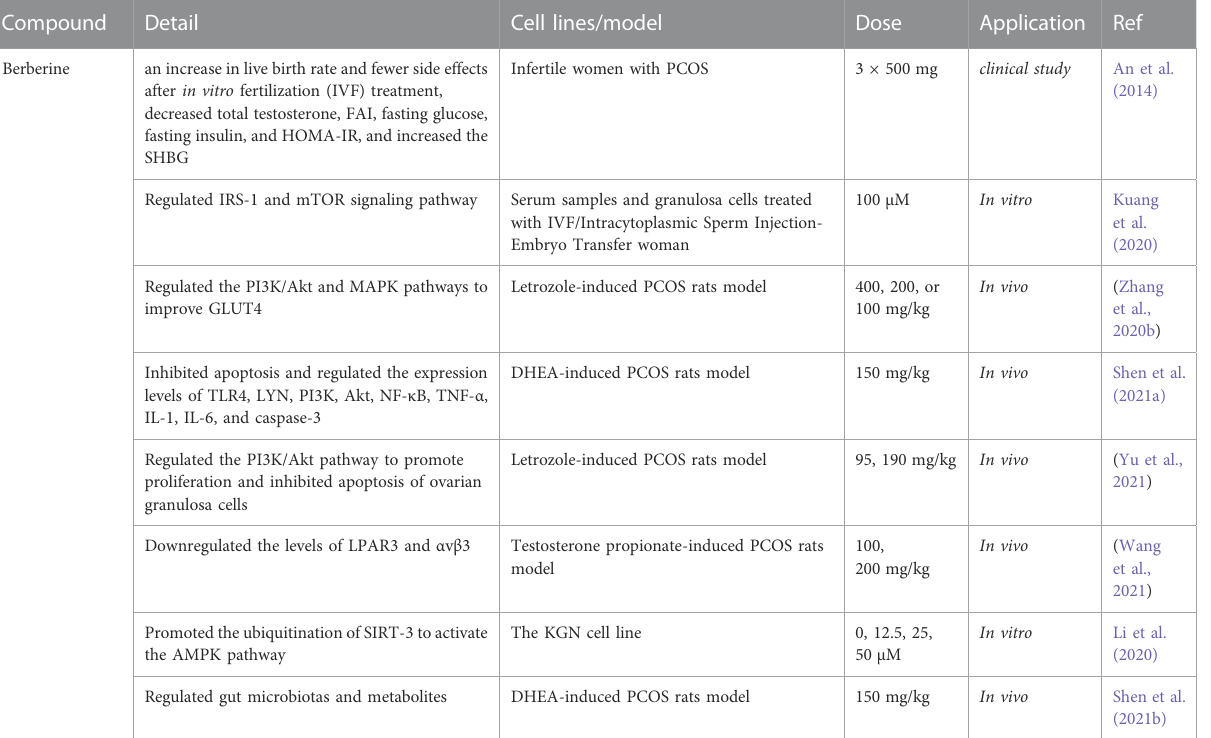
TABLE 3 Therapeutic effects of alkaloids on PCOS.